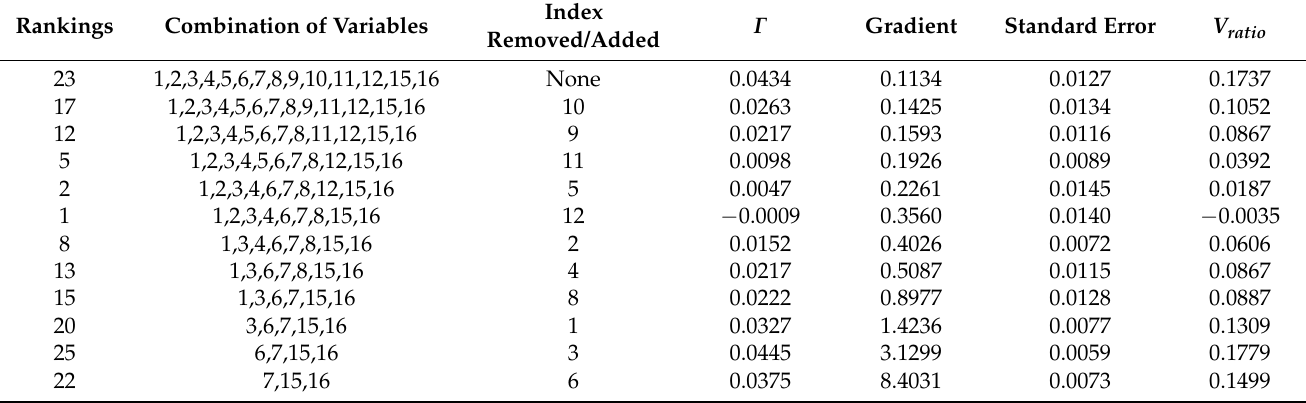
Table 4. Backward and forward selection of variables in the temporal dimension using the Gamma